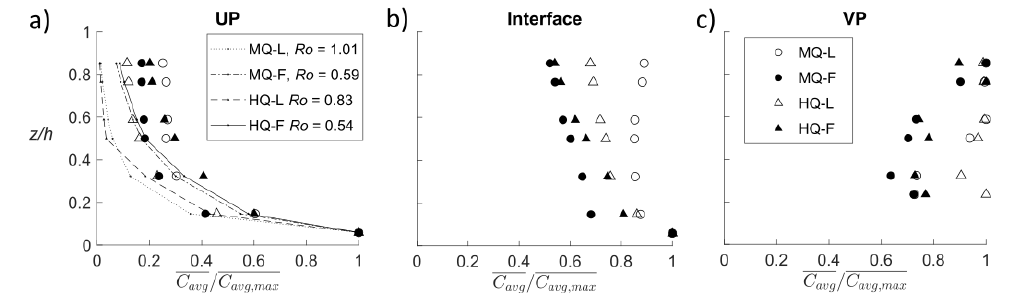
Figure 10. Vertical profiles of the mean time-averaged concentration C avg , normalized with the maximum concentration over the profile C avg , max = max(C 1 , ... , C P ) at ( a ) the unvegetated part (UP) ( y = − 150 mm), ( b ) at the interface ( y = 0 mm), and ( c ) in the vegetated part (VP) (at y = 130 mm) of the channel. The modelled concentrations following the modified Rouse equations (Section 2.4.5) are shown in ( a ); the lines represent the analytical model results based on the near-bed flow velocities u ∗ , and the particle settling velocity w s 50 . MQ = medium flow rate (50 L / s); HQ = high flow rate (83 L / s); L = leafless; F = foliated.